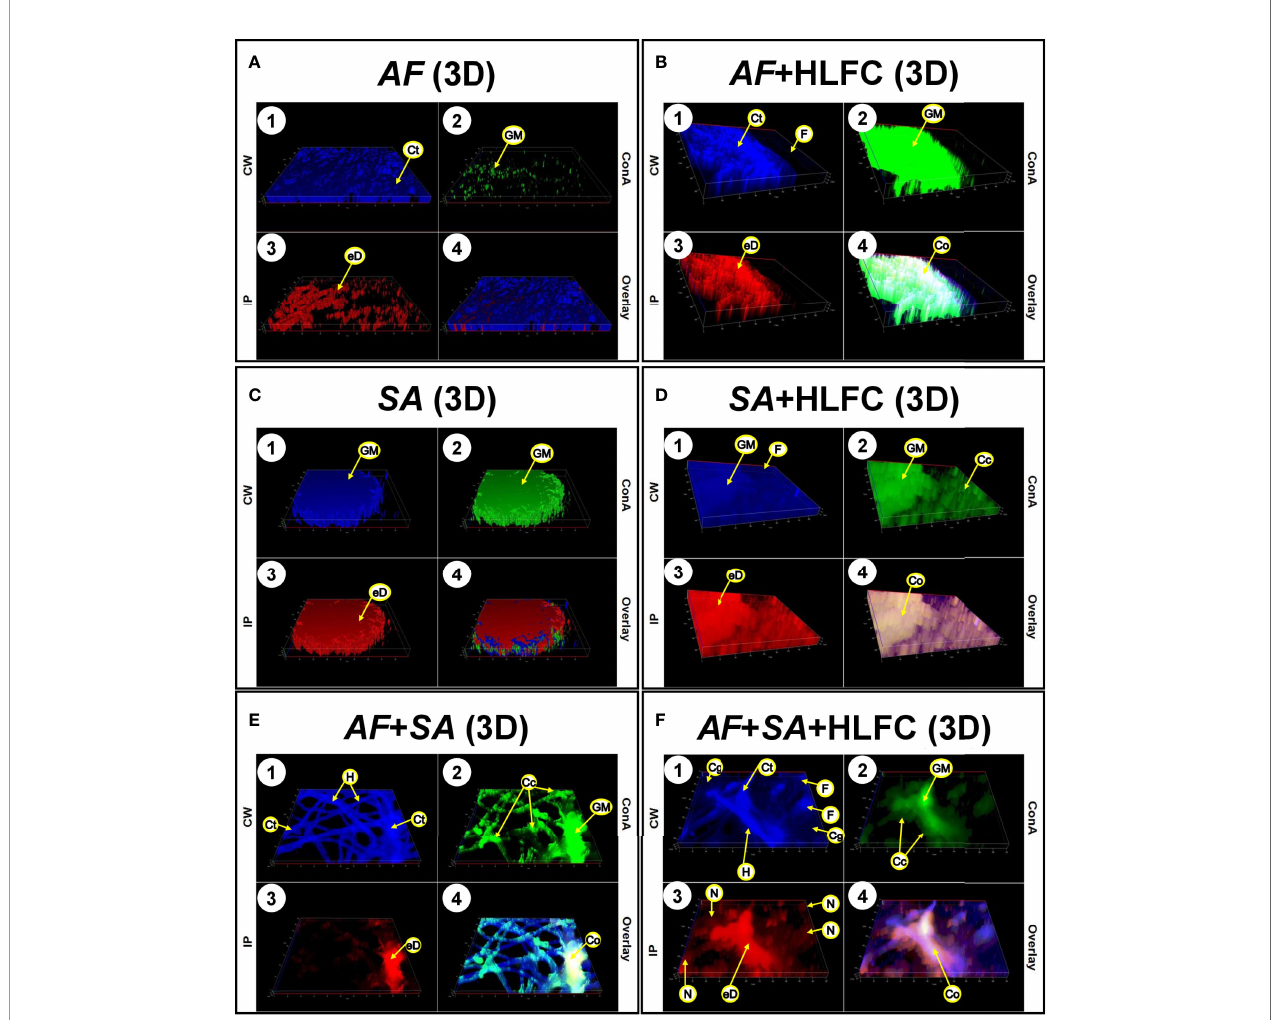
FIGURE 6 | Construction of 3D models of the bio fi lms on HLFCs. AF (A) : a bio fi lm rich in carbohydrates was detected. AF+HLFC (B) : bio fi lm is denser with strong co-localization of the ECM components on the monolayer. In the bacterial 3D model, microcolonies are enveloped in layers of polysaccharides and eDNA, with stronger co-localization in SA+HLFC (D) compared with SA (C) . The ECM was scarce for FBI models, AF+SA (E) , and AF+SA+HLFC (F) , detection of a strong antibiosis over AF. Calco fl uor White (CW: blue-chitin and glycosylated carbohydrates), concanavalin A (ConA: green-glucose and mannose residues), and propidium iodide (PI: red-nucleic acids). Co-localization was obtained by image merging. HLFCs, human limbo-corneal fi broblast cells; AF, Aspergillus fumigatus ; SA, Staphylococcus aureus ; Ct, chitin; GM, N-acetylglucosamine/glucose and mannose residues; eD, extracellular DNA; F, fi broblast; Co, co-localization; H, hypha; Cc, cocci; N,